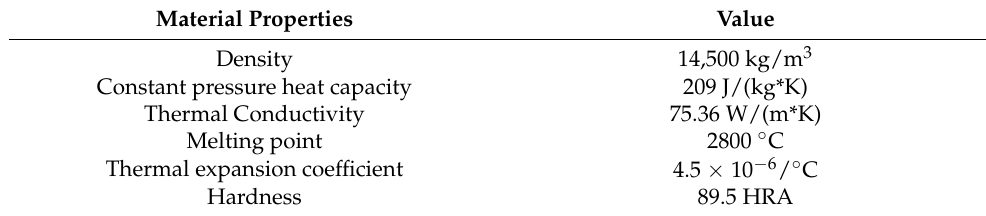
Table 1. Material properties of the edge of the micro-bit.